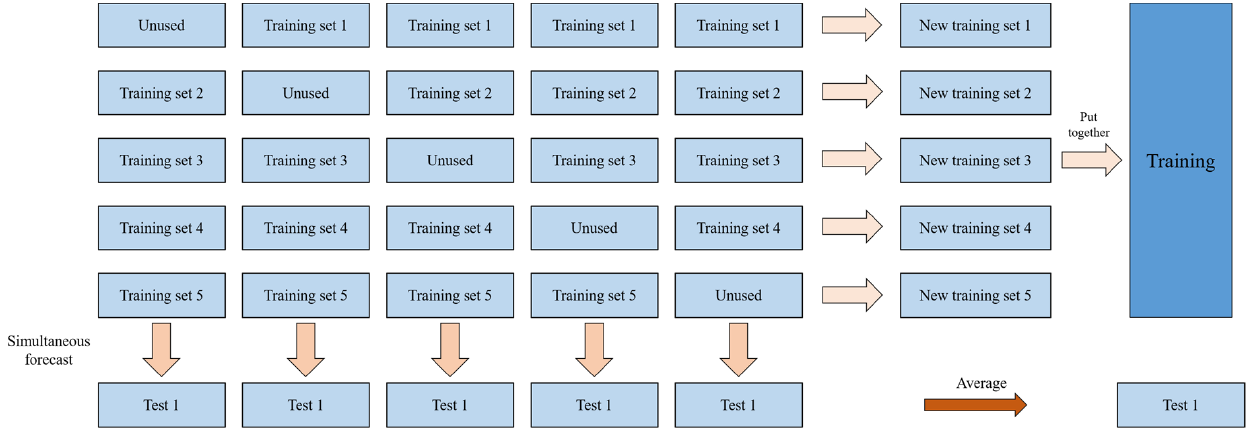
Figure 5. The Stacking Framework of the First Layer of the Training Model.